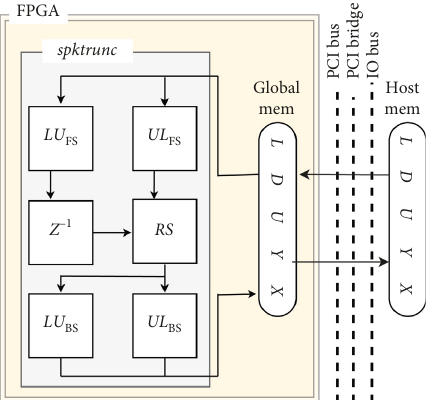
Figure 3: The FPGA truncated SPIKE OpenCL kernel spktrunc , with the execution path and data dependencies shown. The spktrunc executes as a single WI